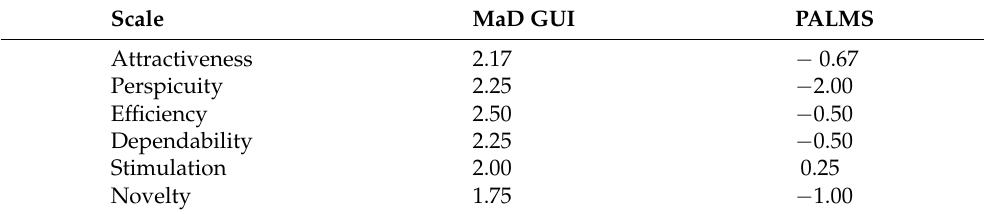
Table 3. User experience questionnaire median scores for the adaptability study. For each item, a score between − 3 (worst) and 3 (best) is